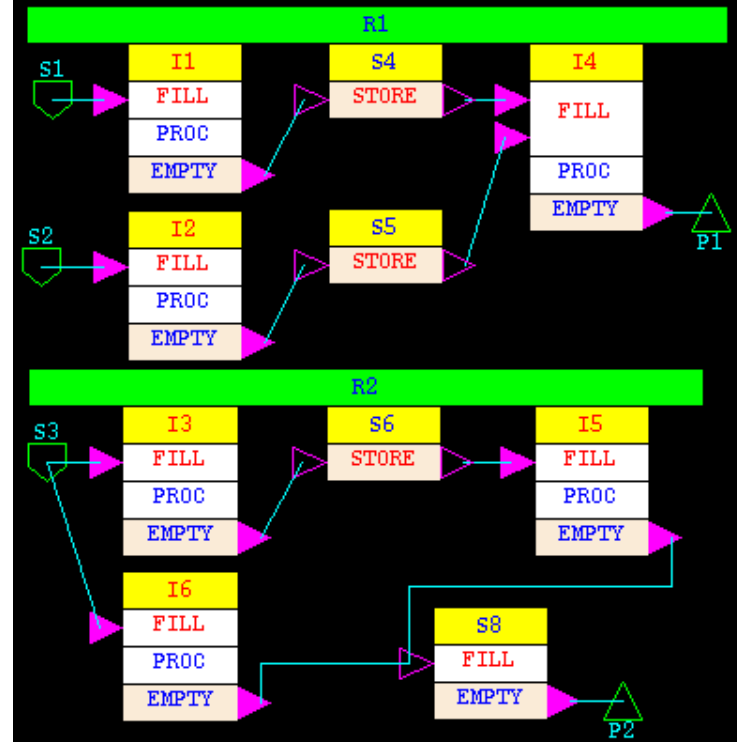
Table 2. Key process parameters for Example 2.